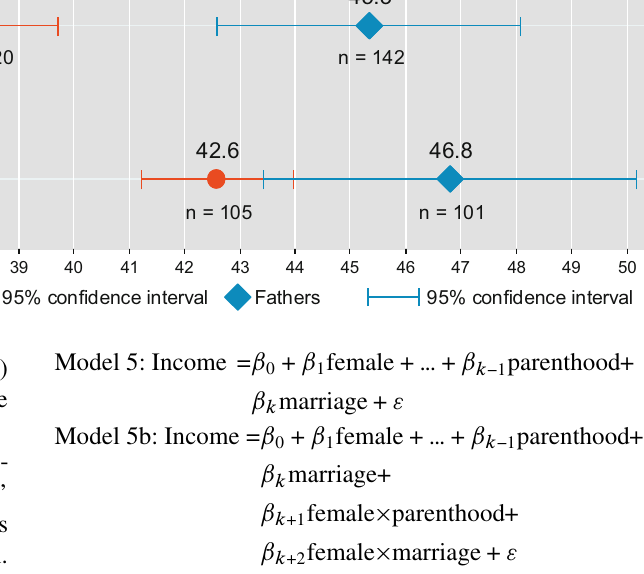
Fig. 2 Hours worked by moth- ers and fathers, separately for sample restricted to year- round full-time working persons ( lower row ) and sample includ- ing part-time and non-year- round working persons ( upper row